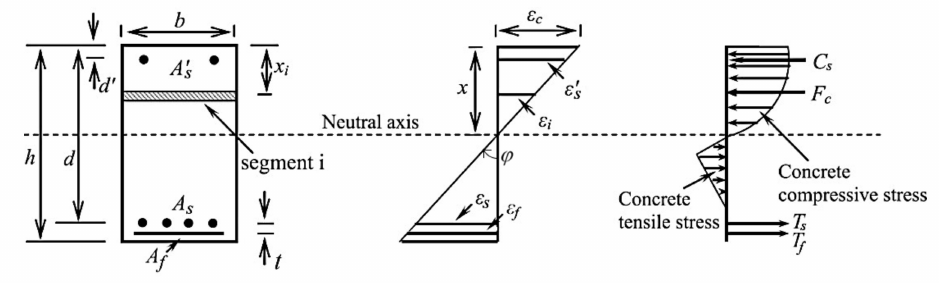
Figure 2. Strains, stresses, and forces of an RC section strengthened with the IRS-SRGM